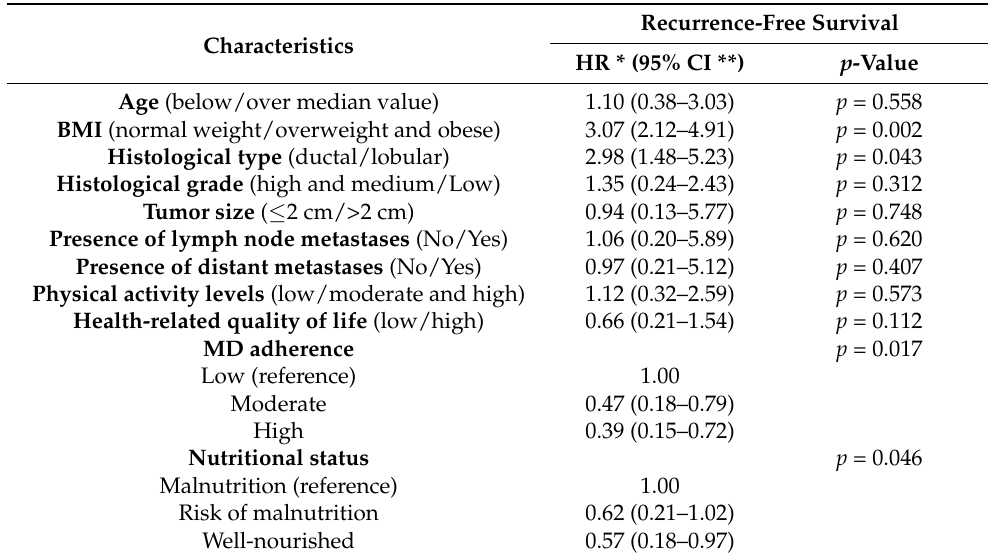
Table 3. Multivariate analysis assessing the impact of MD adherence and nutritional status to recurrence-free patients’